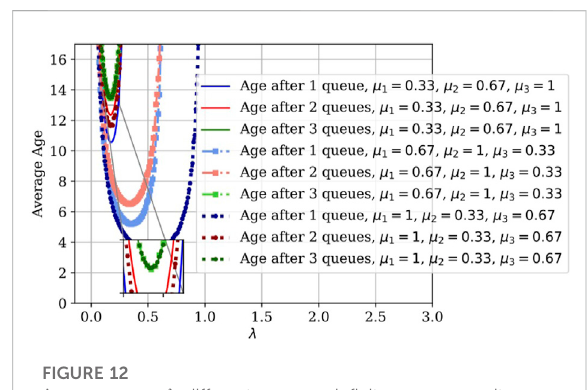
FIGURE 12 Average age vs. λ , different μ 1 , μ 2 , μ 3 , in fi nite queue